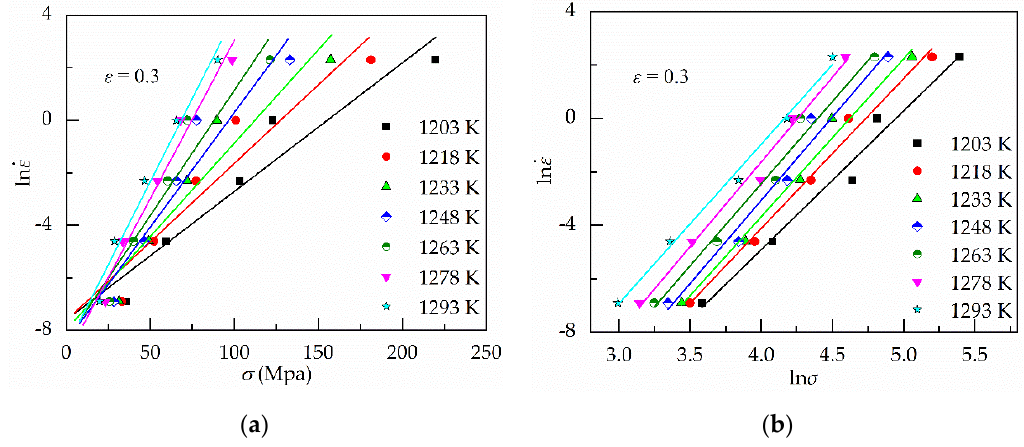
Figure 3. Results of regression analysis for determining α . ( a ) Relationship between σ –ln 𝜀 ̇ ; ( b ) relationship between ln σ –ln 𝜀 ̇ .